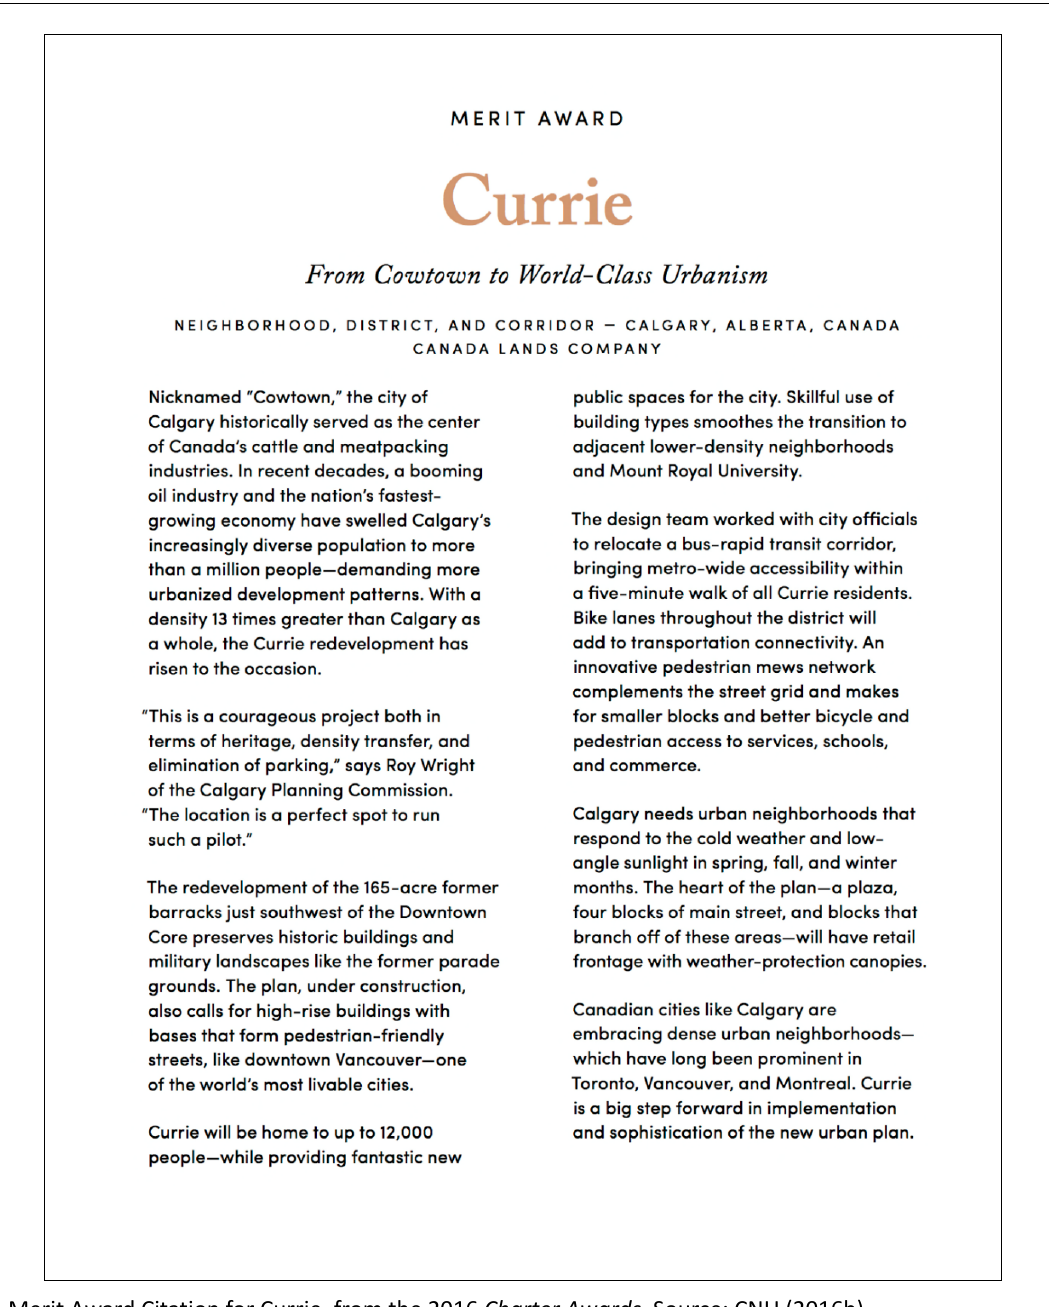
Figure 2. Merit Award Citation for Currie, from the 2016 Charter Awards . Source: CNU (2016b). I had two goals for this year’s awards program.